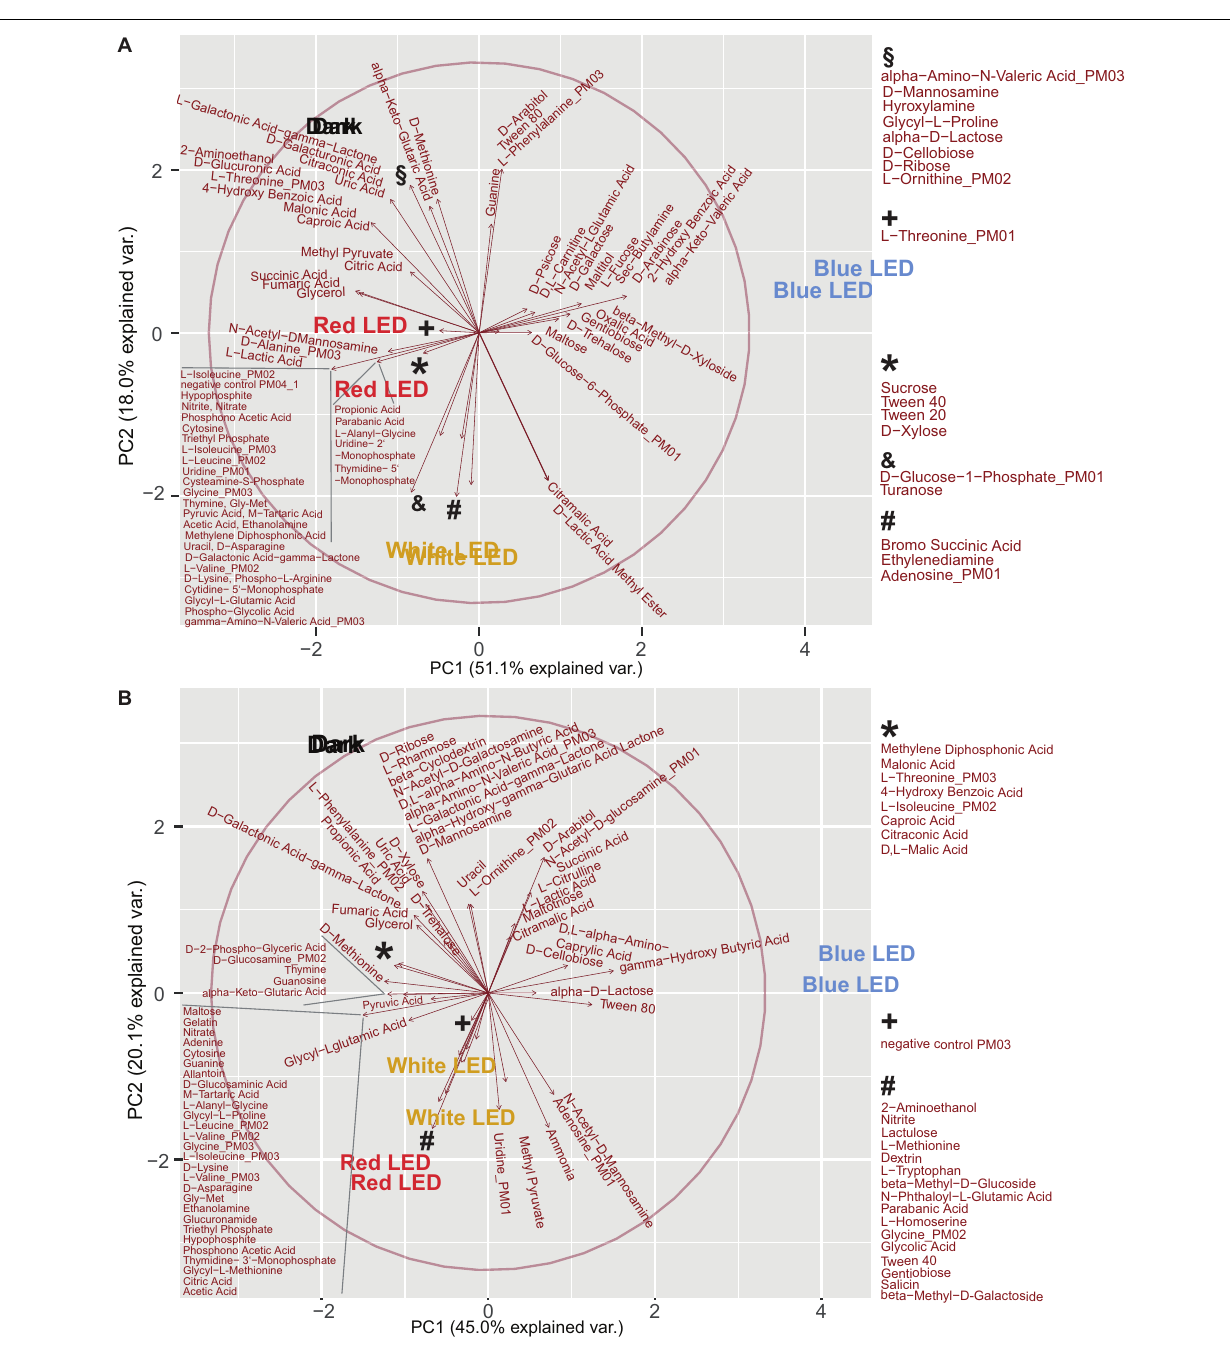
FIGURE 6 | Principal component analysis (score plots, loading plots) of light regime and substrate utilization interactions on biosurfactant formation of P. agarici (A) and Pseudomonas sp. DR 5-09 (B) . The analysis was based on two repetitions. These two repetitions display a very similar picture for the scores, therefore the text for the treatments is close to each other or